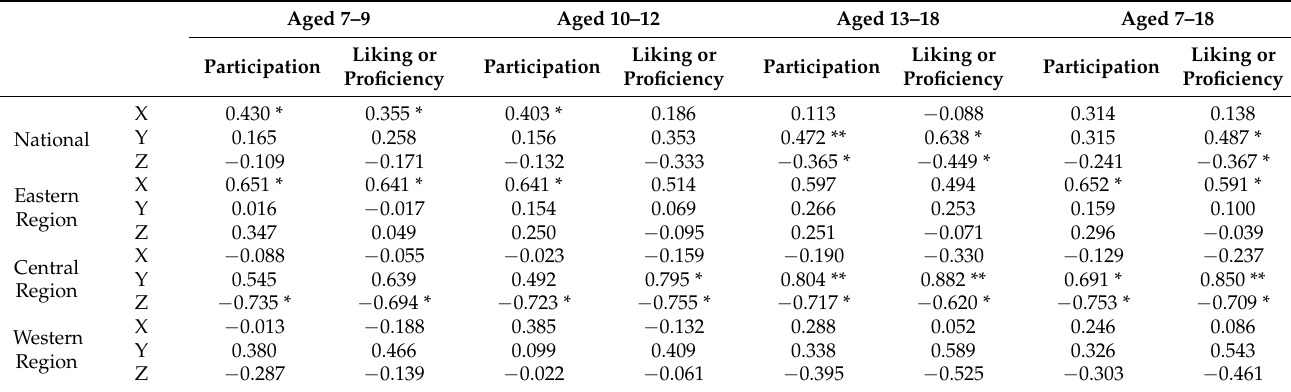
Table 5. Correlation analysis of the “soccer population” of children and adolescents with the natural